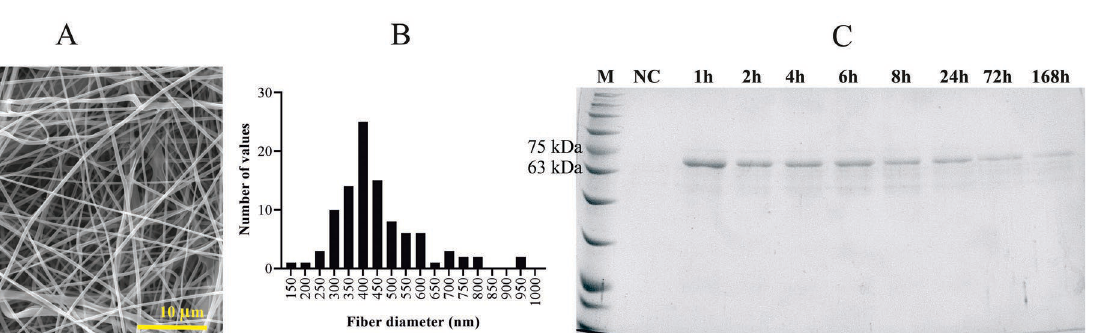
Figure 3. SEM image of electrospun collagen nano/submicrofibers ( A ; mag. 50,000×) and collagen